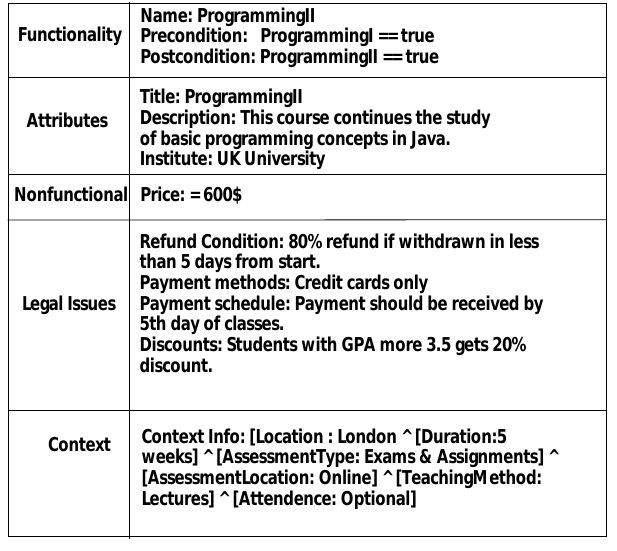
Figure 6. New ProgrammingII ExtendedService